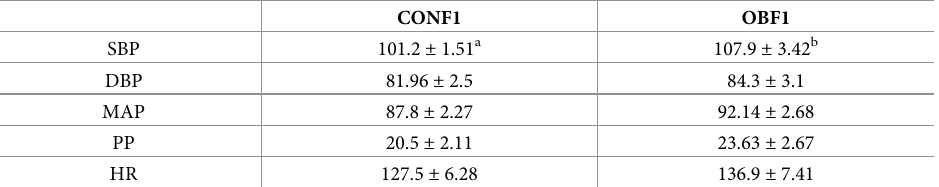
Table 1. F1 lambs invasive blood pressure. Measurements for CONF1 (n = 9) and OBF1 (n = 6) lambs at 2.5 months of age.